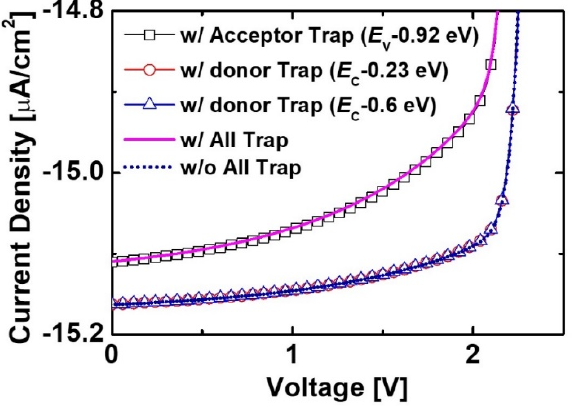
Figure 9. E ff ects of trap states on current characteristics of the e-beam-irradiated diodes. The H p-GaN and H i-GaN in the diode were 100 nm and 700 nm, respectively. D p-GaN , D i-GaN , and D n-GaN were 5 × 10 17 cm − 3 , 1 × 10 16 cm − 3 , and 5 × 10 18 cm − 3 , respectively.